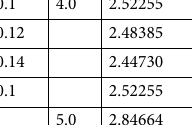
k nf ′ ( 0 ) with respect to γ and k f θ